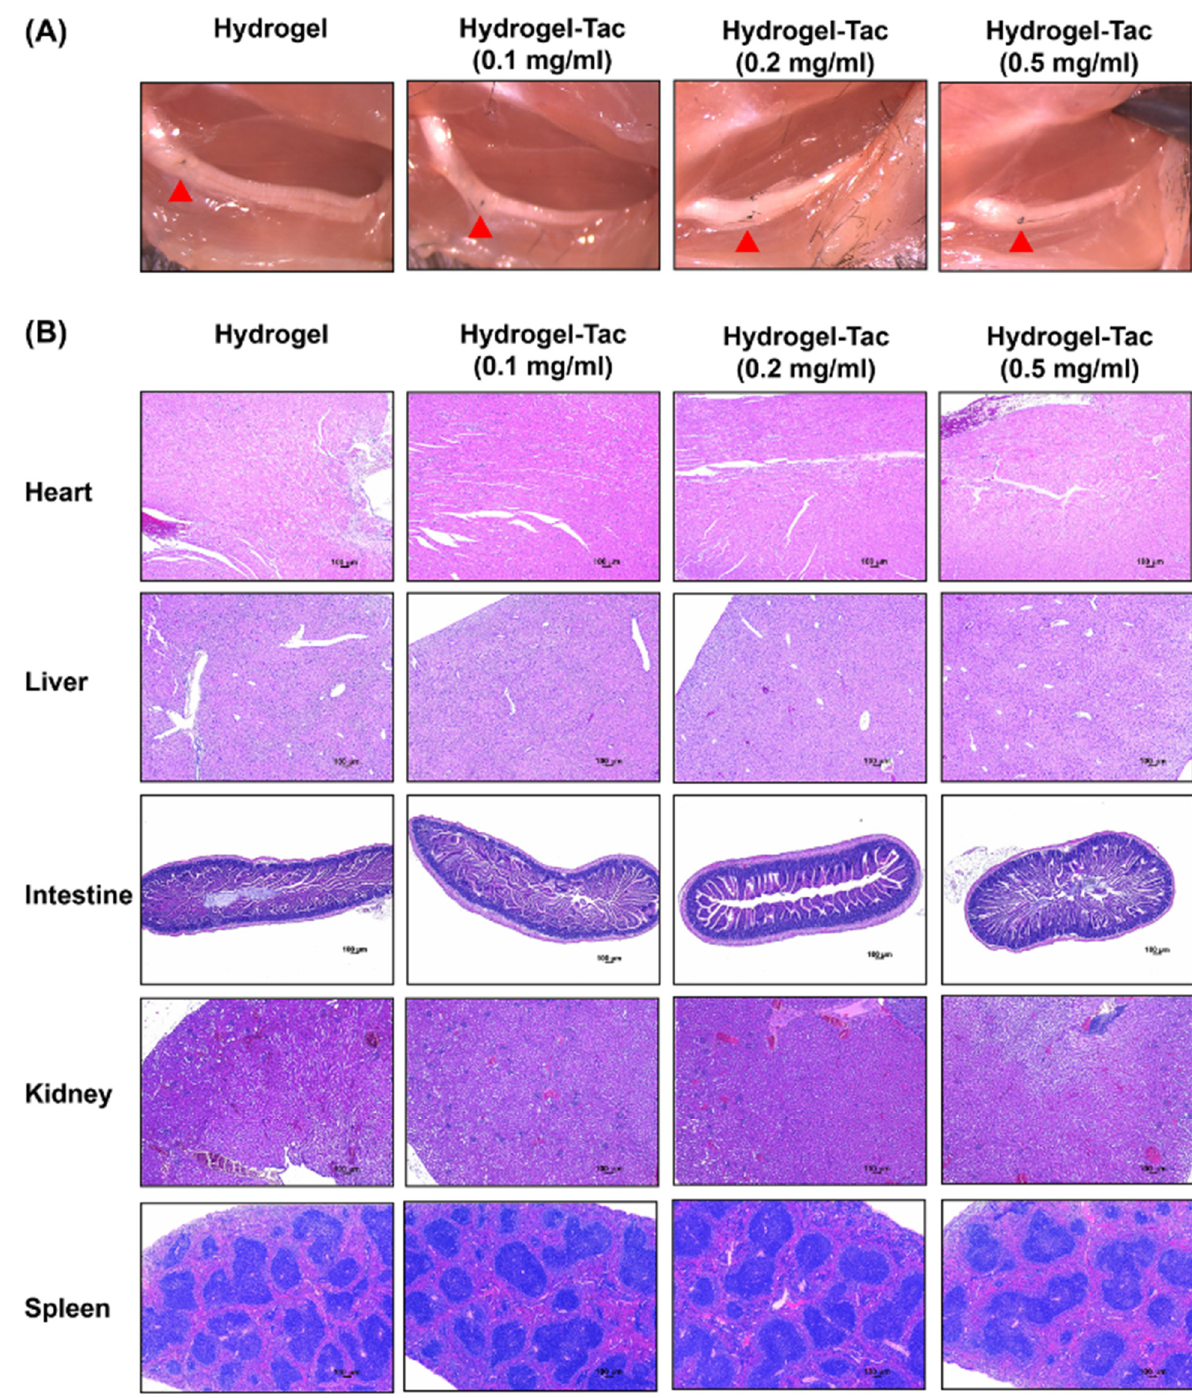
Figure 7. The long-term safety profile of Hydrogel-Tac in mouse transected sciatic nerve model. In the hydrogel and Hydrogel-Tac groups, the sciatic nerves of the mice’s right hindlimb were cut and then anastomosed with 10/0 sutures. Subsequently, 0.1 mL of hydrogel or encapsulated-tacrolimus hydrogel was injected into the subcutaneous space of the right hindlimb. ( A ) Macroscopic examination of the sutured sciatic nerve over 289 days in different groups. The sutured site of surgical repair is indicated by the red arrow. ( B ) Microscopic evaluation of various organs stained with hematoxylin and eosin in different groups. The scale bars are 100 μ m.